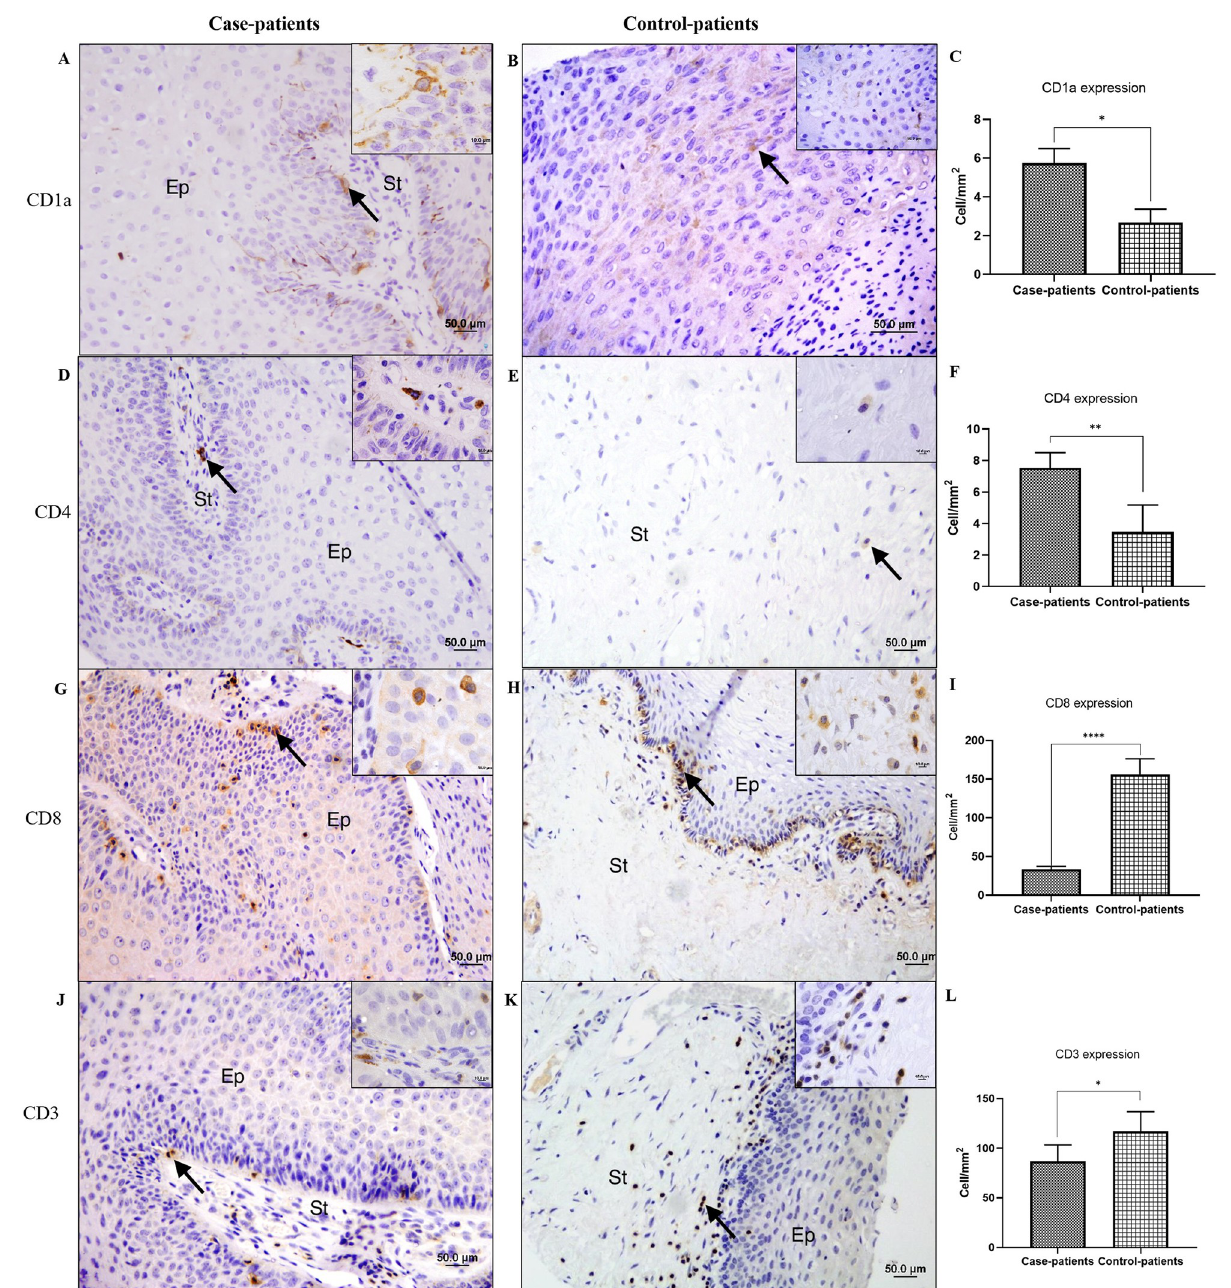
Fig 4. Immunohistochemical assays. Photomicrographs and graphics showing the punctual staining pattern of CD1a, corresponding to Langerhans cells (A-C), CD4 (D-F), CD8 (G-I), and CD3 (J-L) expression. Scale bars: 50 μ M in the main pictures and 10 μ M in the insets. ANOVA was followed by the Tukey‘s Multiple comparison test ( ± S.E.M. * = p < 0.01, ** = p < 0,001 and **** = p < 0.0001). Arrows: positive immunostaining for different markers; Ep: stratified squamous epithelium; St: connective tissue stroma of the dermis.